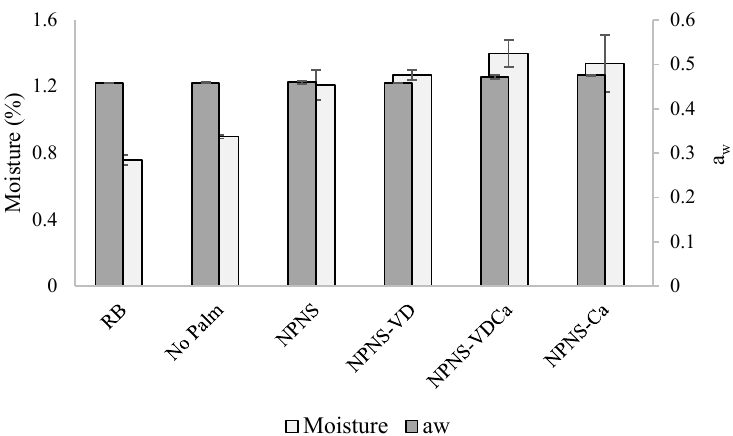
Figure 3. Moisture (%) and water activity (aw) of the spreadable chocolates. RB, reference brand; NPNS, spreadable chocolate without palm oil and sugar; NPNS-VD, spreadable chocolate without palm oil and sugar fortified with vitamin D; NPNS-VDCa, spreadable chocolate without palm oil and sugar fortified with vitamin D and Mg-CaCO 3 nanoparticles; NPNS-Ca, spreadable chocolate without palm oil and sugar fortified with Mg-CaCO 3 nanoparticles. As reported by Vu et al. [31], in low moisture food, a w is one of the factors that could impact lipid oxidation. Moreover, the scrutiny of data reported in Figures 2 and 3 revealed a reduction in the lag phase for the PV with an increased moisture content of the spread- able creams. Figure 4 represents the plot of the maximum rate of hydroperoxide produc- tion as a function of the temperature storage. Figure 4. Maximum rate hydroperoxides production plotted as a function of the storage tempera- ture. RB, reference brand; NPNS, spreadable chocolate without palm oil and sugar; NPNS-VD, spreadable chocolate without palm oil and sugar fortified with vitamin D; NPNS-VDCa, spreadable chocolate without palm oil and sugar fortified with vitamin D and Mg-CaCO3 nanoparticles; NPNS- Ca, spreadable chocolate without palm oil and sugar fortified with Mg-CaCO3 nanoparticles. As a general rule, the maximum amount of hydroperoxides produced increased slowly and almost linearly from 288.15 K to 303.15 K before starting to sharply rise ac- cording to the storage temperature. A pronounced increase rate was found in NPNS sam- ples, where the chocolate spread without palm oil and sugar fortified with vitamin D and